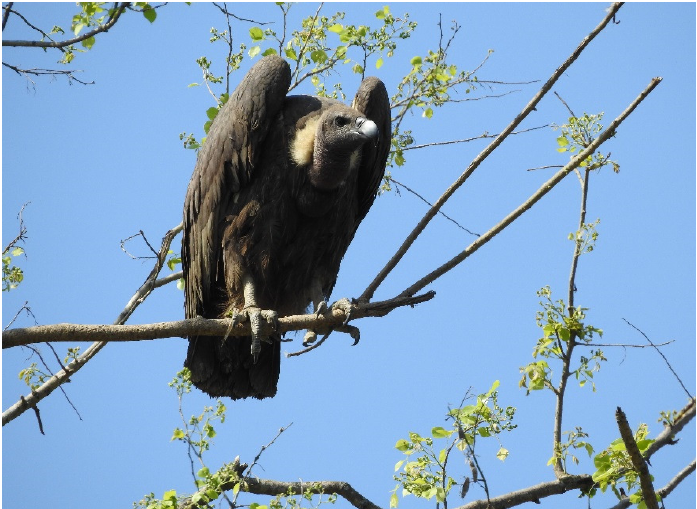
Figure 6. Tree nesting, critically endangered, resident White-rumped vulture Gyps bengalensis perched on a Sheesham tree, Dalbergia sissoo